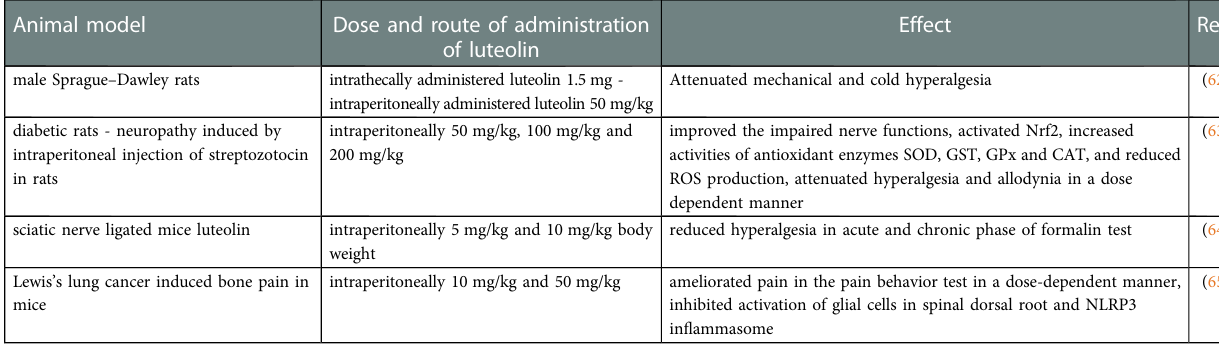
TABLE 4 In vivo studies of luteolin ’ s analgesic effects in neuropathic models. Animal